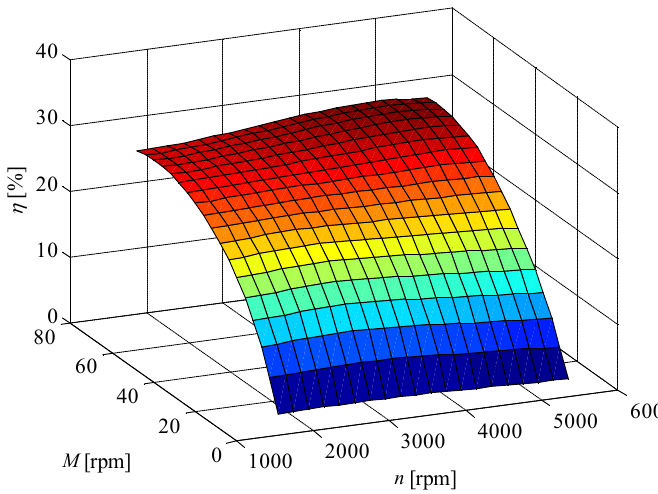
Figure 9. Engine efficiency characteristic in static states. Figure 9. Engine e ffi ciency characteristic in static states.